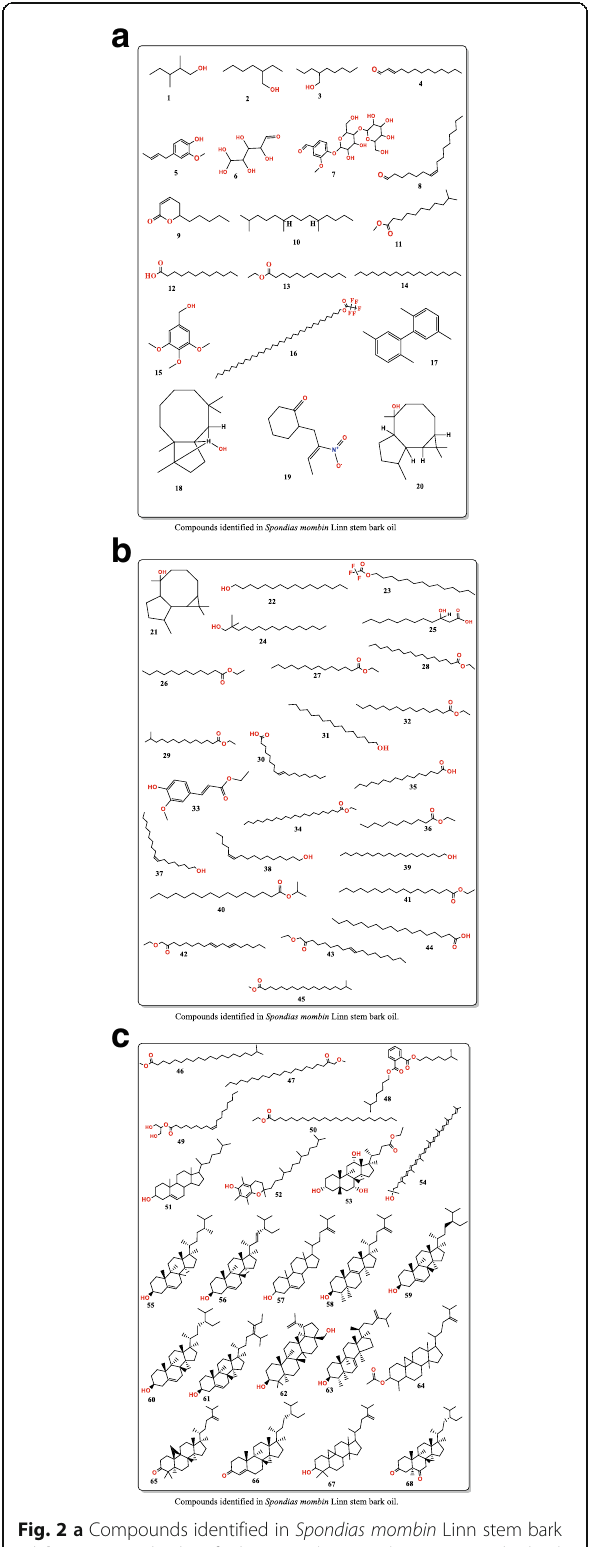
Fig. 2 a Compounds identified in Spondias mombin Linn stem bark oil. b Compounds identified in Spondias mombin Linn stem bark oil. c Compounds identified in Spondias mombin Linn stem bark